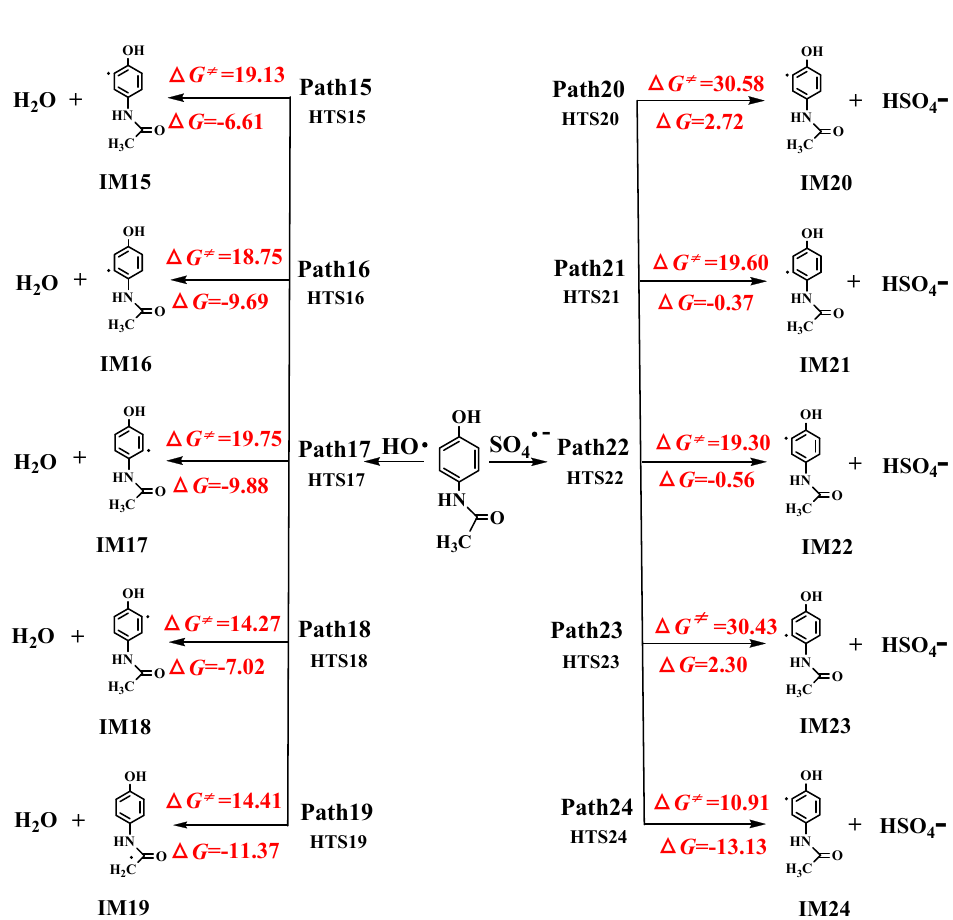
Figure 4. The formal hydrogen atom transfer channels of AAP with • OH and SO 4 •− reactions with the Gibbs free energy of reaction ( Δ G ) and Gibbs free energy barrier of activation ( Δ G ≠ ) (unit: kcal/mol).